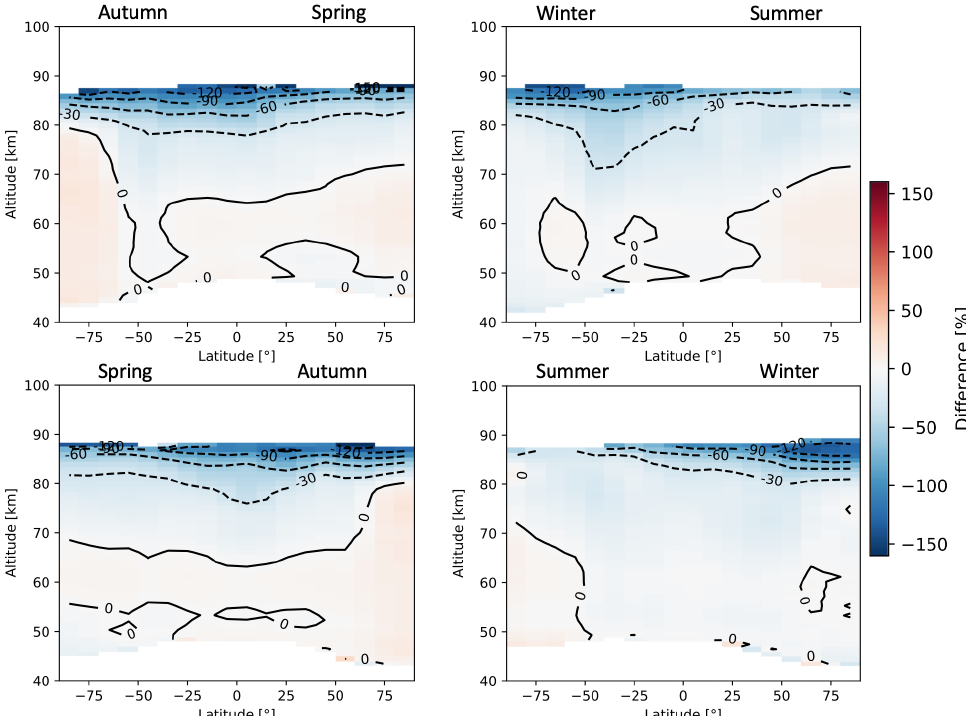
Figure A18. Seasonal zonal means of H 2 O FM13 SMR–MLS relative differences averaged over the time period between July 2004 and April 2019. The seasons are intended as astronomical seasons, i.e. each starting at the respective solstice or